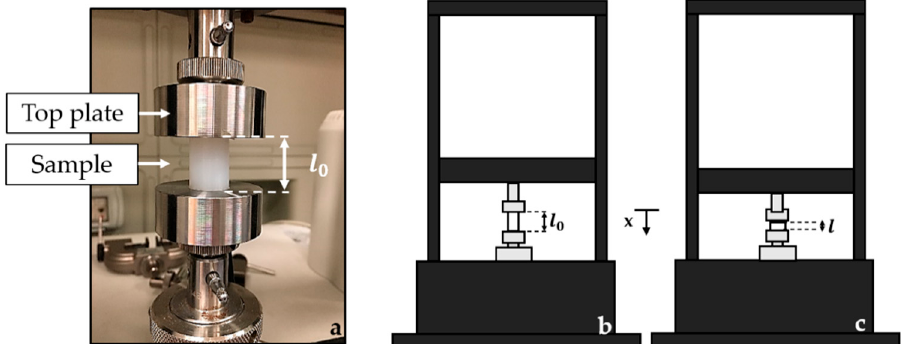
Figure 1. Set-up of the compression tests ( a ): the cylinder-shaped sample between the lower and the upper plates of the Instron machine and the initial sample length before (l 0 ) and during the compression (l) are illustrated ( b and c , respectively). The top plate moves at constant speed parallel to the x -axis ( c ).